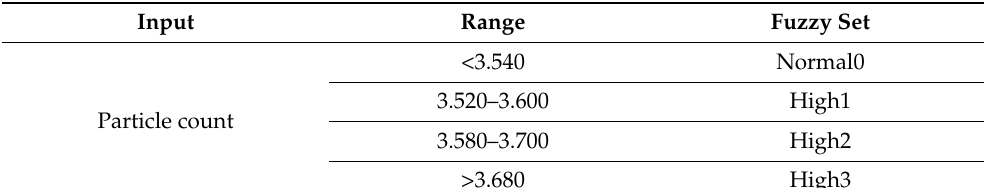
Table 4. Ranges of the particle count and their respective fuzzy sets.